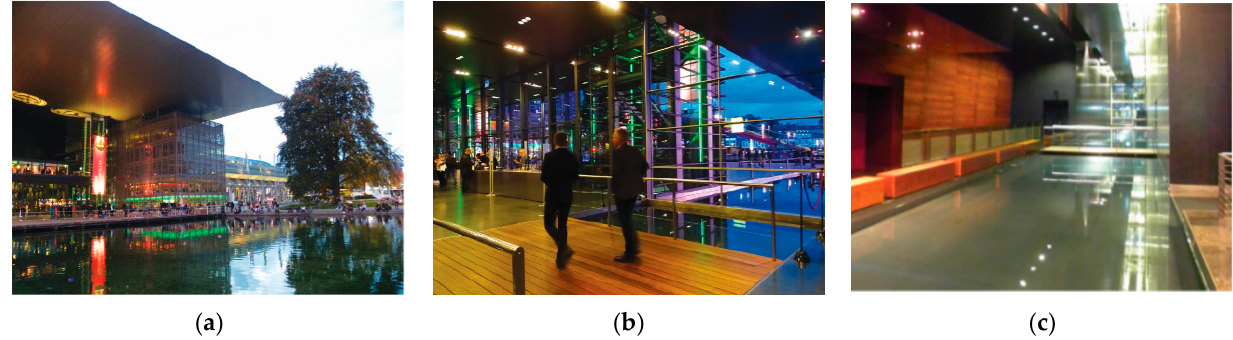
Figure 11. Kultur- und Kongresszentrum Luzern: ( a ) front façade seen from Europaplatz and ( b , c ) water ducts between the modules of the building; photograph by B. Majerska-Pa ł ubicka.